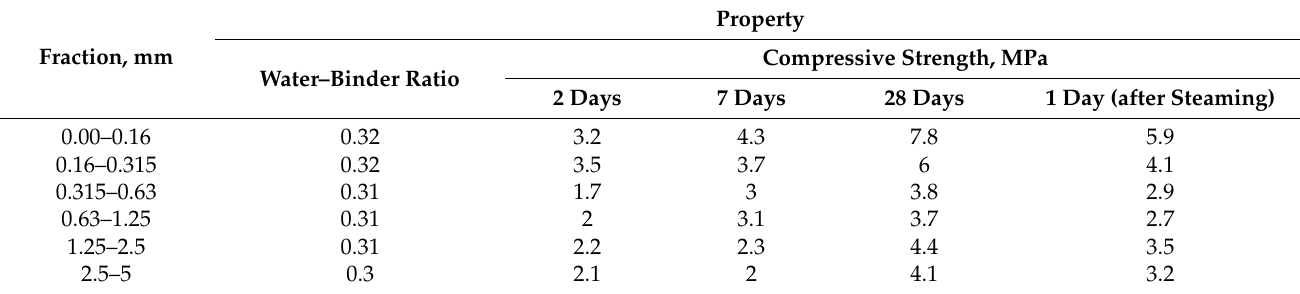
Table 3. Physical and mechanical properties of binders depending on the